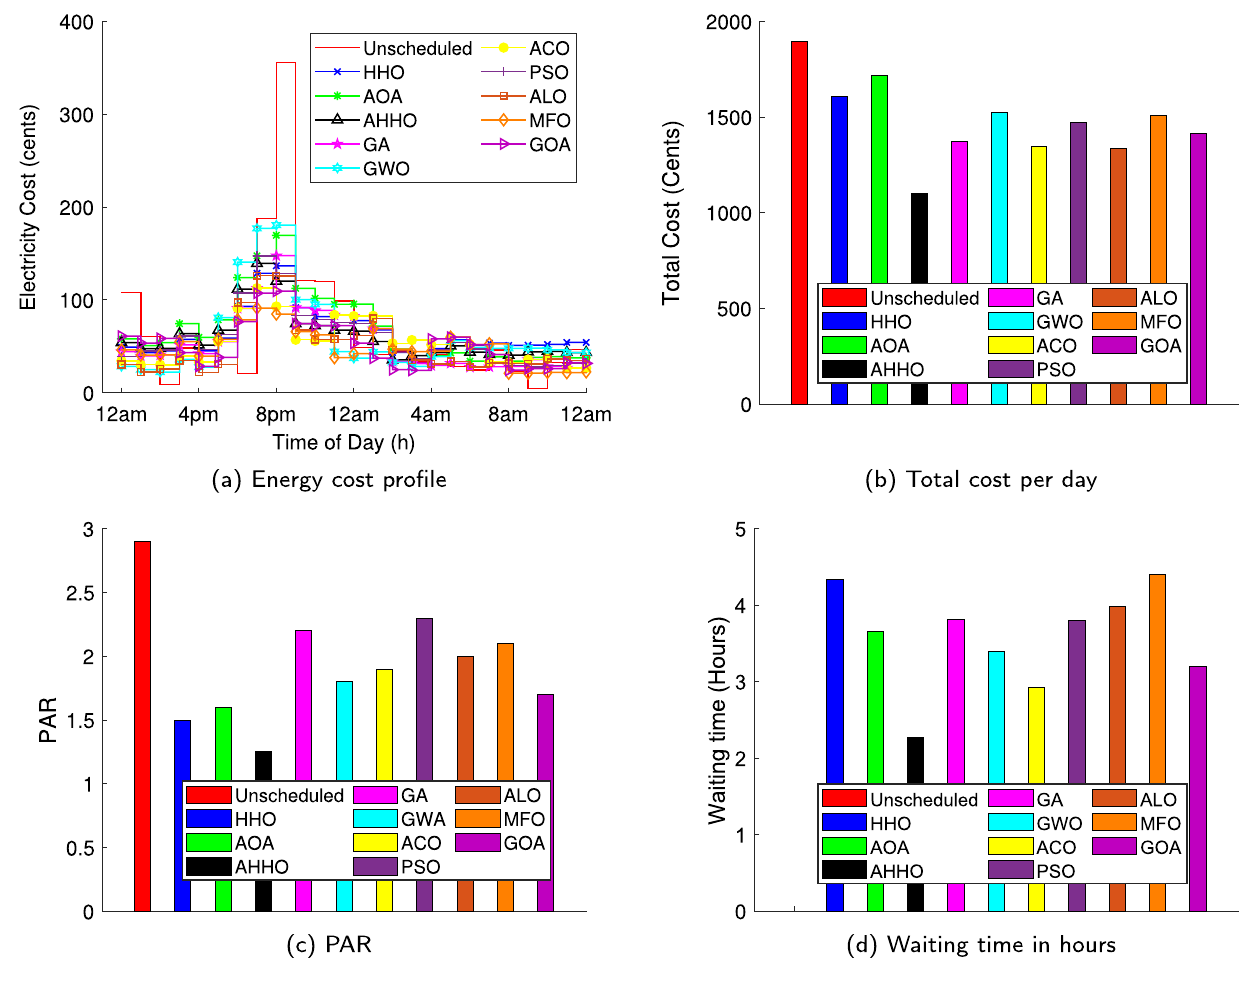
Fig. 6 Results of RTP